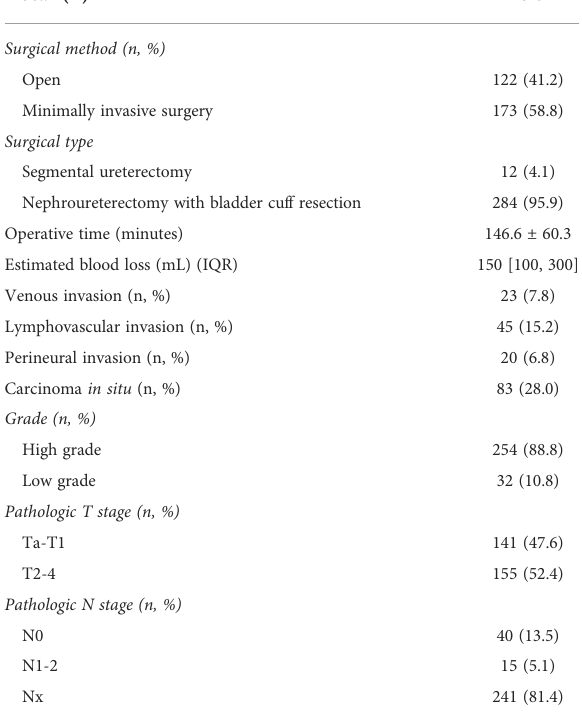
TABLE 2 Perioperative